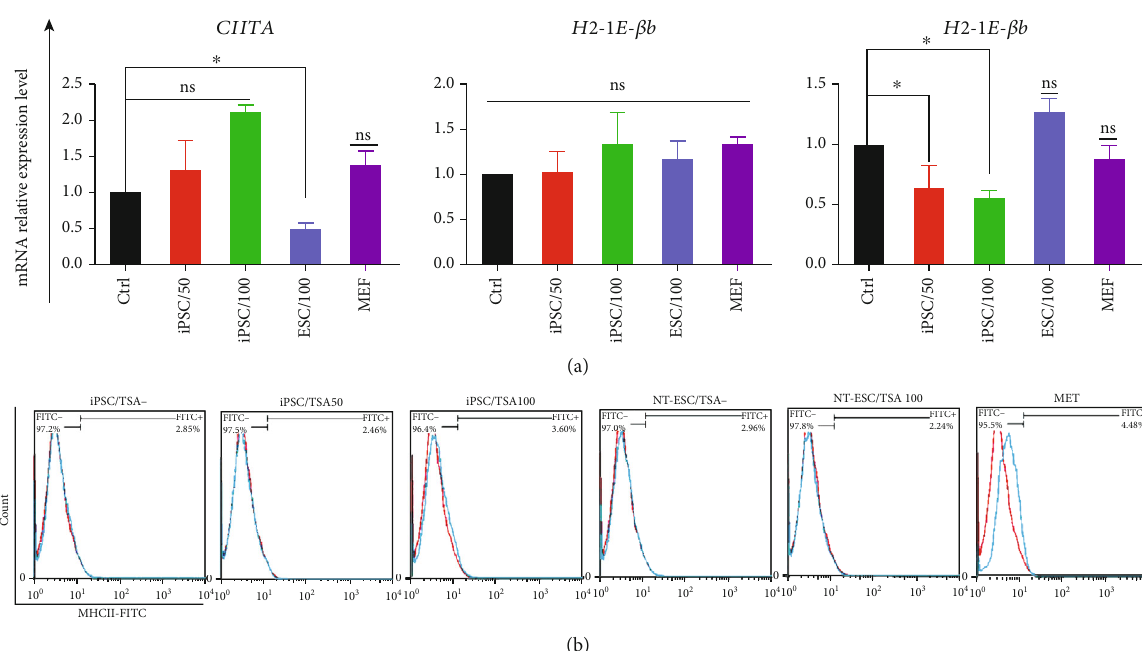
Figure 5: CIITA and MHC class-II expression level. (a) Histograms show the real-time PCR analysis of CIITA, H2-IE - β b , and H2-IE- β d in TSA-positive and negative iPSCs and ESCs. MEF cells studied as parental somatic cell. (b) Flow cytometry analysis of the expression of MHC II molecules on the surface of ESCs, iPSCs, and MEF cells. ns: not signi fi cant; ∗ indicates the statistical signi fi cance, P < 0 : 05